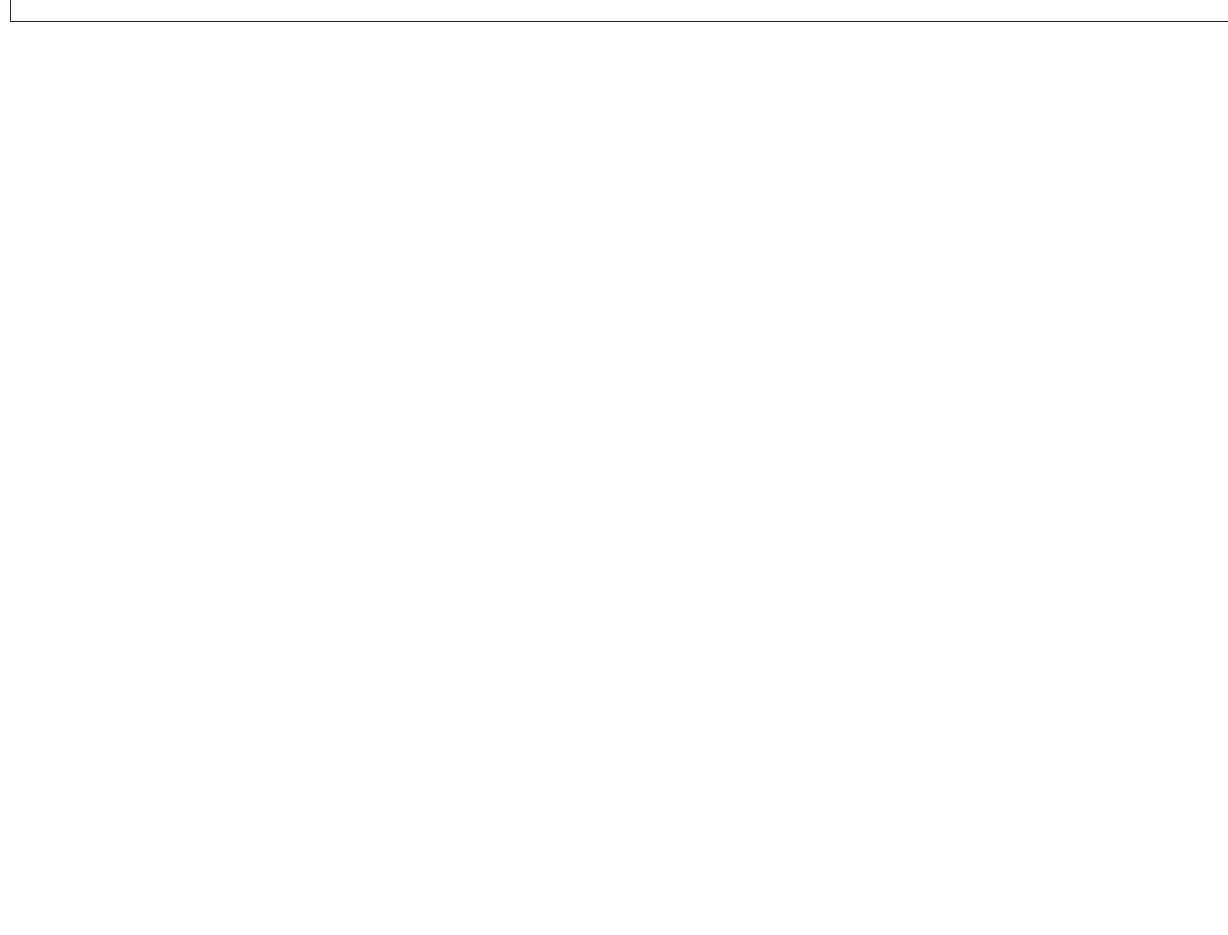
FrontiersinNutrition